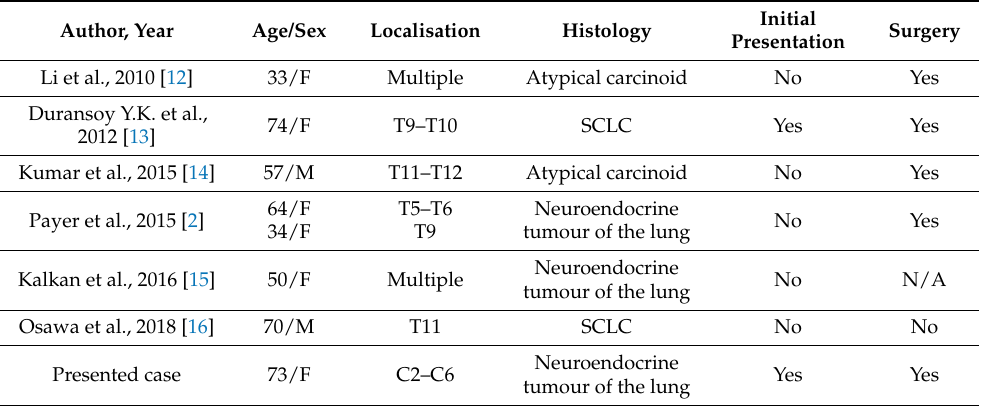
Table 1. Reported cases of intramedullary spinal cord metastasis from neuroendocrine lung tu- mours